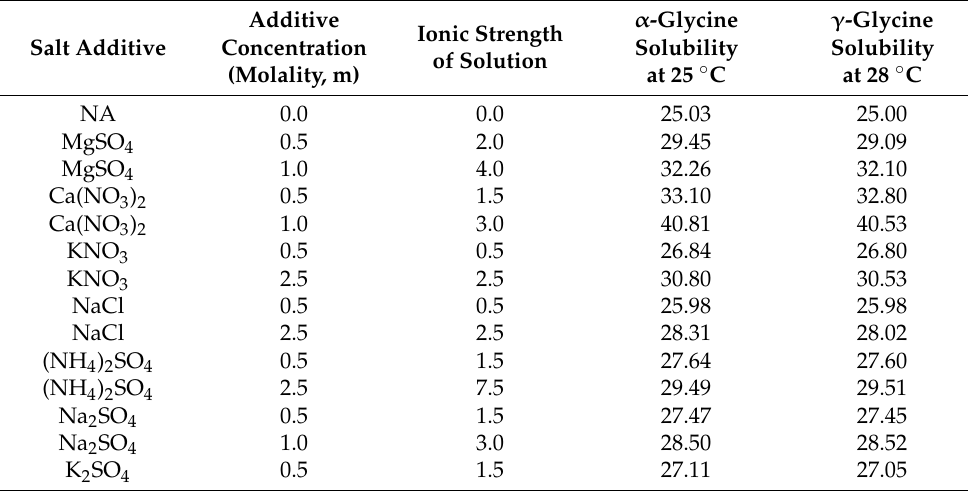
Table 1. Solubilities (g/100 g H 2 O) of glycine polymorphs in aqueous solutions with salt additives at 25 ◦ C and 28 ◦